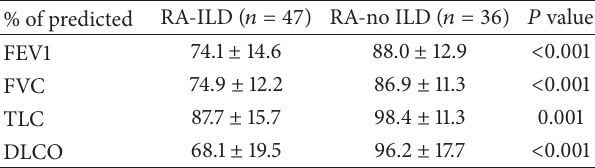
Table 3: Lung HRCT scores of RA-ILD and RA-no ILD. HRCT